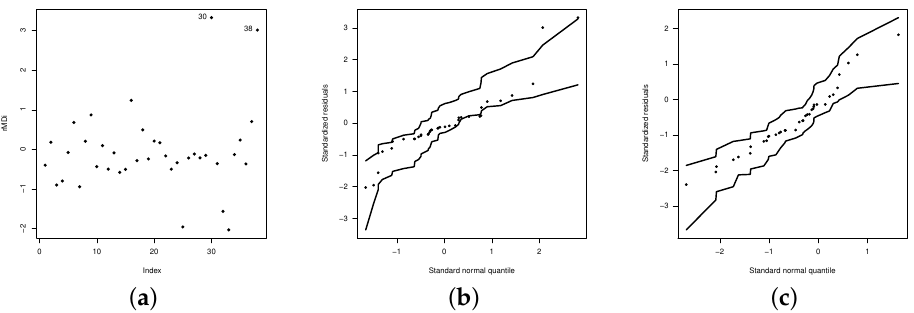
Figure 8. ( a ) Plots of the residuals rMT i for the UPSN regression model. Envelope for the UPSN regression model with outliers ( b ), and without outliers ( c ). Table 7. Estimations of the parameters, with their standard errors, of the regression model UPSN. ˆ β 0